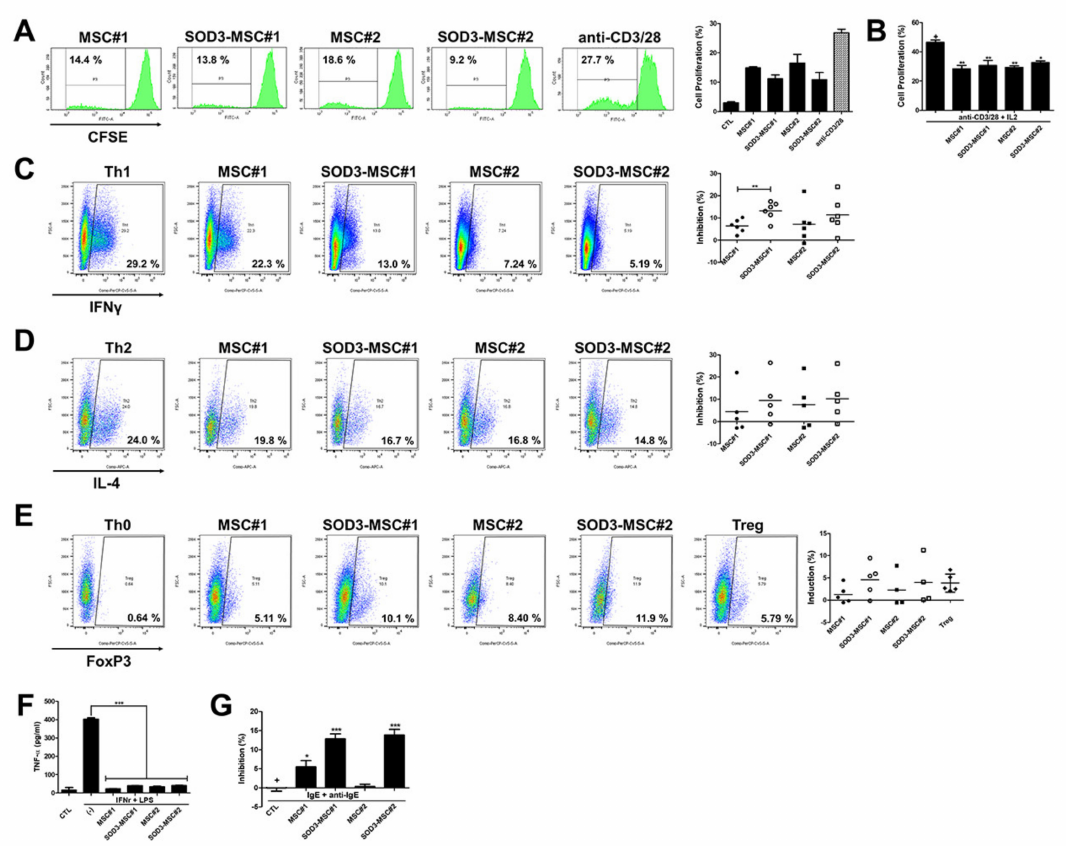
Figure 3. The immunomodulation of SOD3-MSCs. ( A ) The peripheral blood mononuclear cell (PBMC) proliferation without any stimulants was detected by CFSE assay in the presence of MSCs (MSC:PBMC = 1:10), using transwell co-culture. Proliferation in the positive control group was induced with anti-CD / 28. ( B ) Proliferation of anti-CD3 / CD28 activated CFSE-labelled CD4 + T cells co-cultured with MSCs or SOD3-MSCs. ( C – E ) Representative dot plots and accumulated values showing the percentages of Th1 ( C ), Th2 ( D ), and Treg ( E ) cells in CD4 + T cells co-cultured with MSCs or SOD3-MSCs. ( F ) THP-1 derived macrophages were activated and co-cultured with MSCs or SOD3-MSCs. TNF- α level in culture media was detected by ELISA. ( G ) β -hexosaminidase content was measured in the supernatants from activated LAD-2 cells. Results are shown as mean ± SD. *, **, and *** represent p < 0.05, p < 0.01, and p < 0.001, respectively. p -value significance was calculated by comparing other groups against the ( + ) group (marked as + ). • : MSC#1, : SOD3-MSC#1, (cid:4) : MSC#2 and (cid:3) : (cid:35)